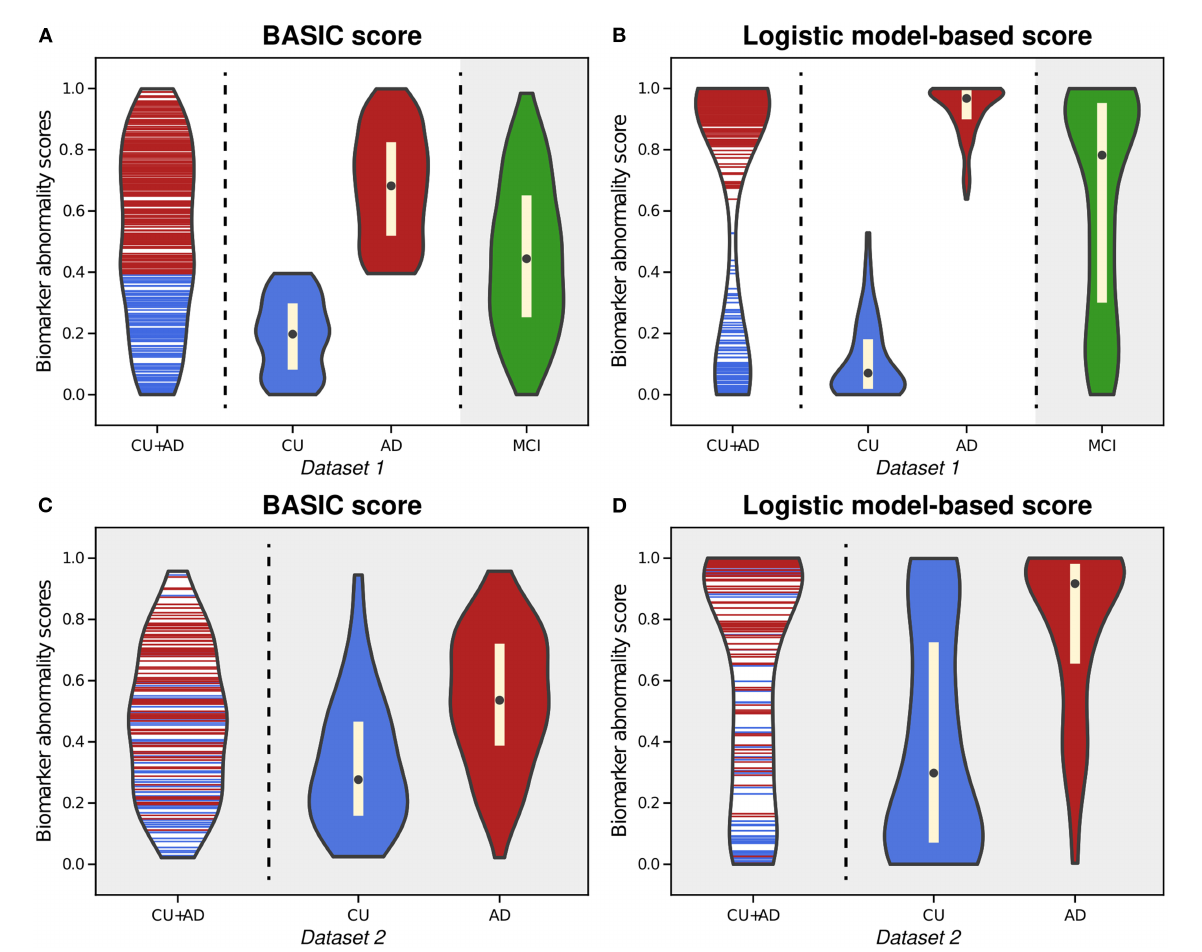
FIGURE2 Violin plots illustrating the estimated distributions of BASIC scores (A) and logistic model-based scores (B) from whole-brain functional connectivity networks of cognitively unimpaired (CU) individuals and patients with Alzheimer’s disease (AD) in Dataset 1. We also calculated the scores of patients with mild cognitive impairment (MCI) using both methods with parameter derived from CU and AD people (gray-shaded areas in (A,B) . For external validation, we calculated the BASIC scores (C) and logistic-model based scores (D) of CU and AD individuals in Dataset 2 from parameters obtained using CU and AD individuals in Dataset